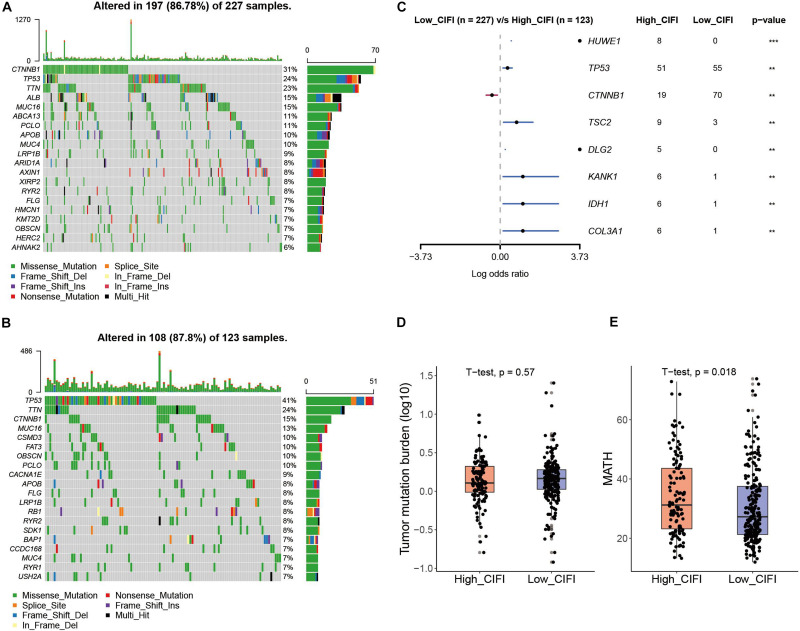
Somatic mutation in the CIFI-stratified groups. (A,B) Oncoplots of the mutated genes in the (A) low-CIFI and (B) high-CIFI subgroups of the TCGA cohort. (C) Forest plot of the differentially mutated genes between the high- and low-CIFI groups. (D) TMB and (E) MATH scores in the high- and low-CIFI groups.